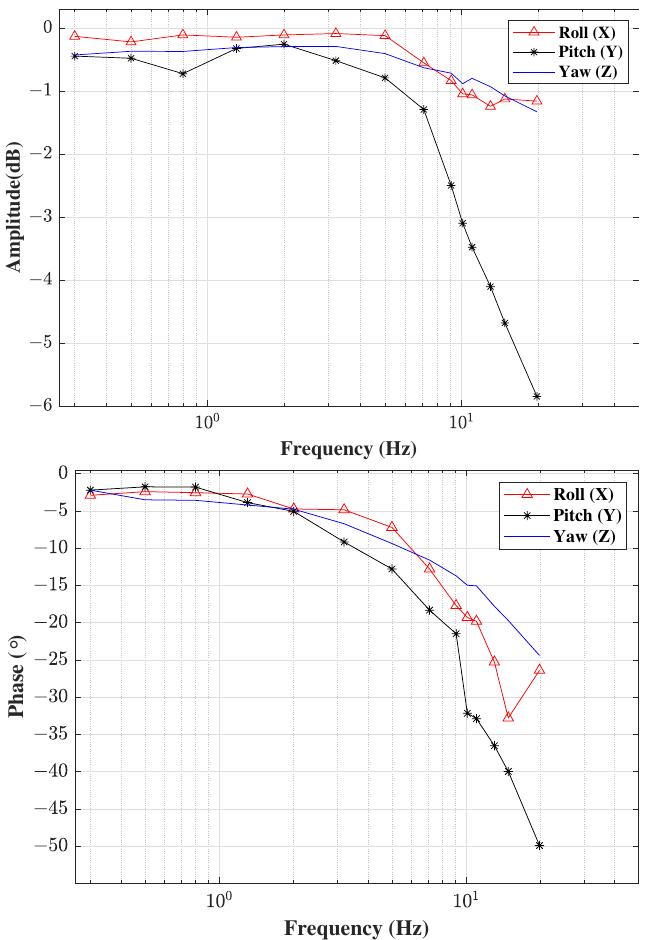
Figure 9. The Bode plot for a rotational describing function under TSMC on Cartesian